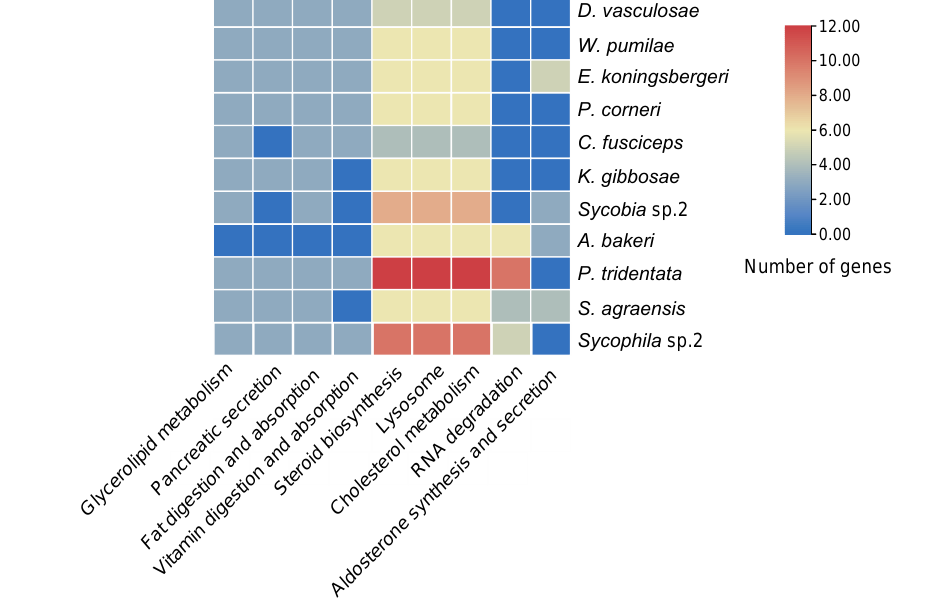
Figure 6. KEGG enrichment of lipase genes in 11 fig wasp species. Only data with a p value after Bonferroni correction of less than 0.05 are shown. The change of color ranging from orange to blue represents the number of lipase genes ranging from large to small.